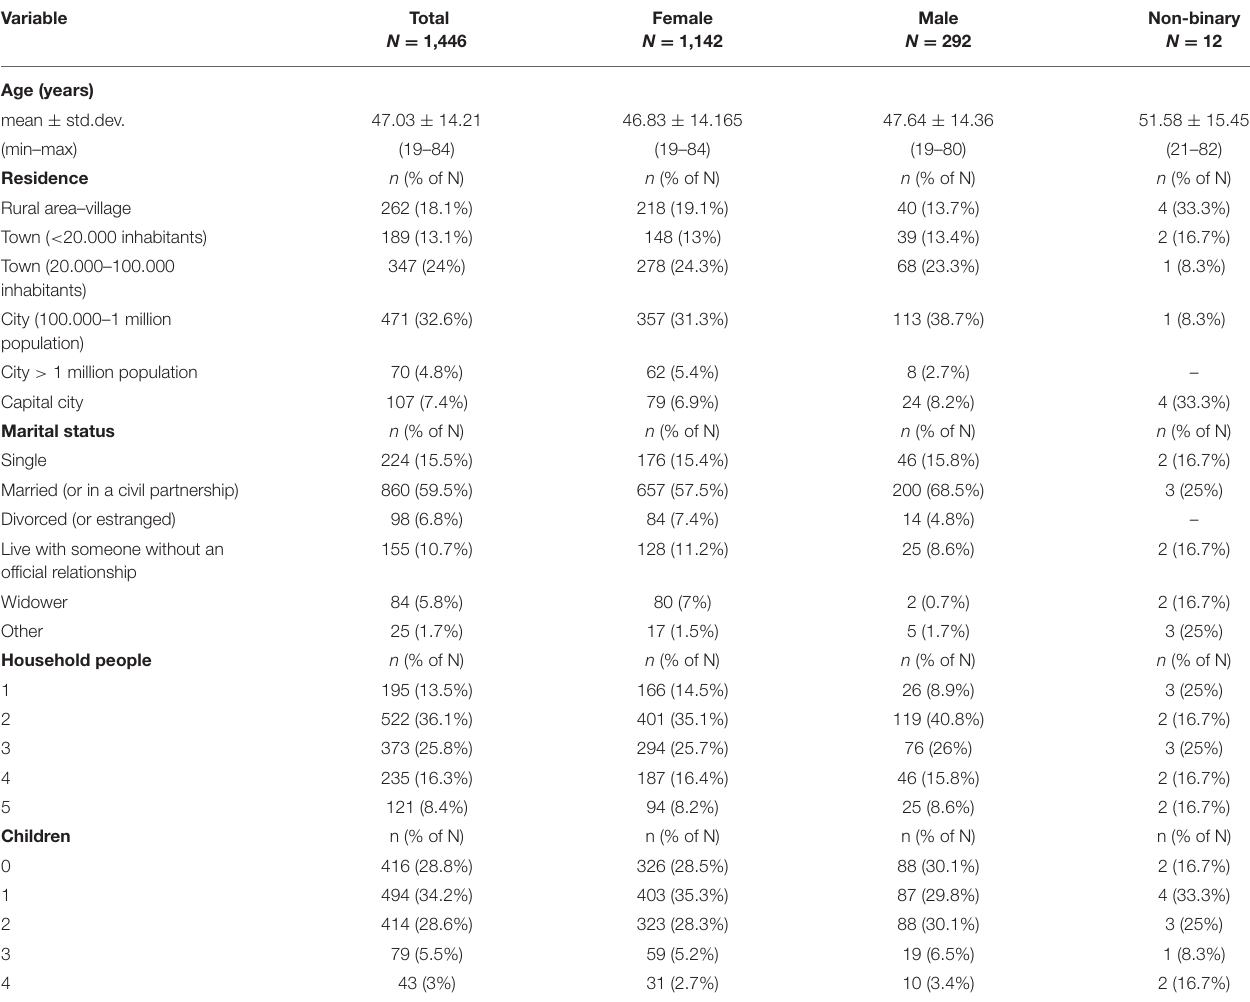
TABLE 2A | Socio-demographic characteristics of the respondents.